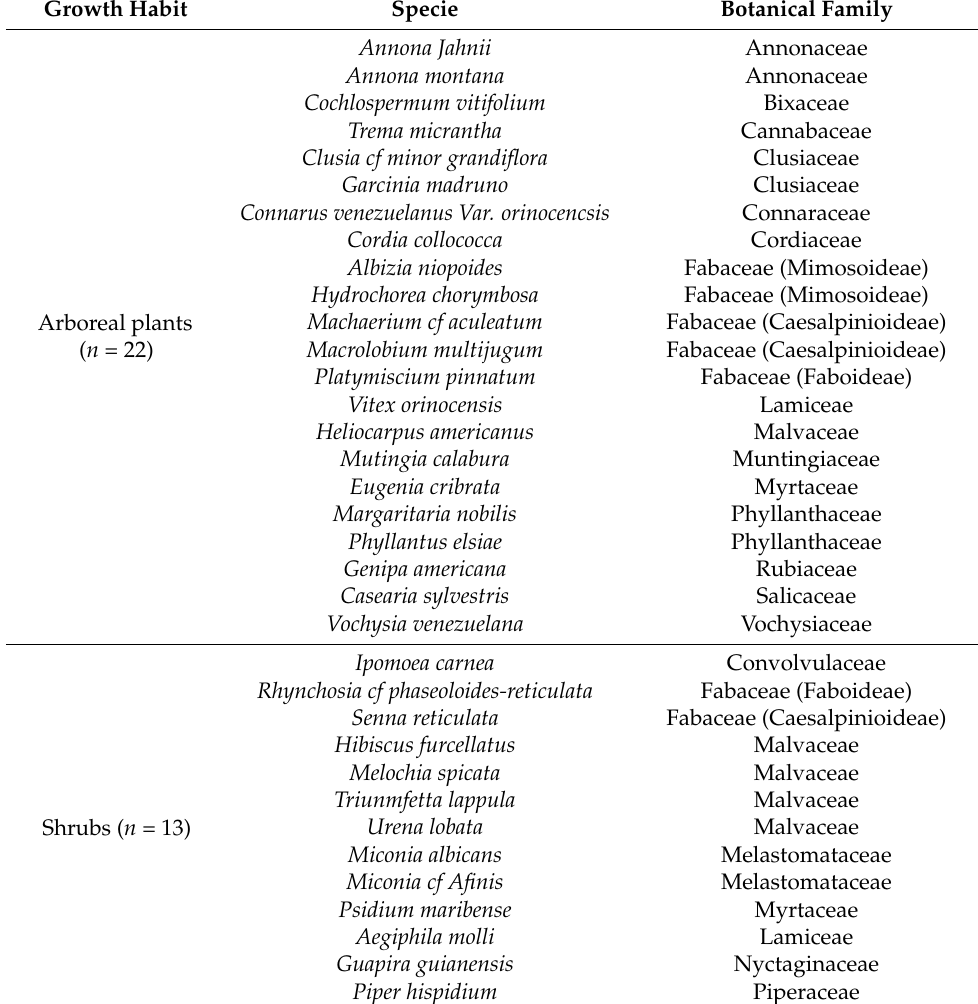
Table 1. Botanical characteristics of the selected